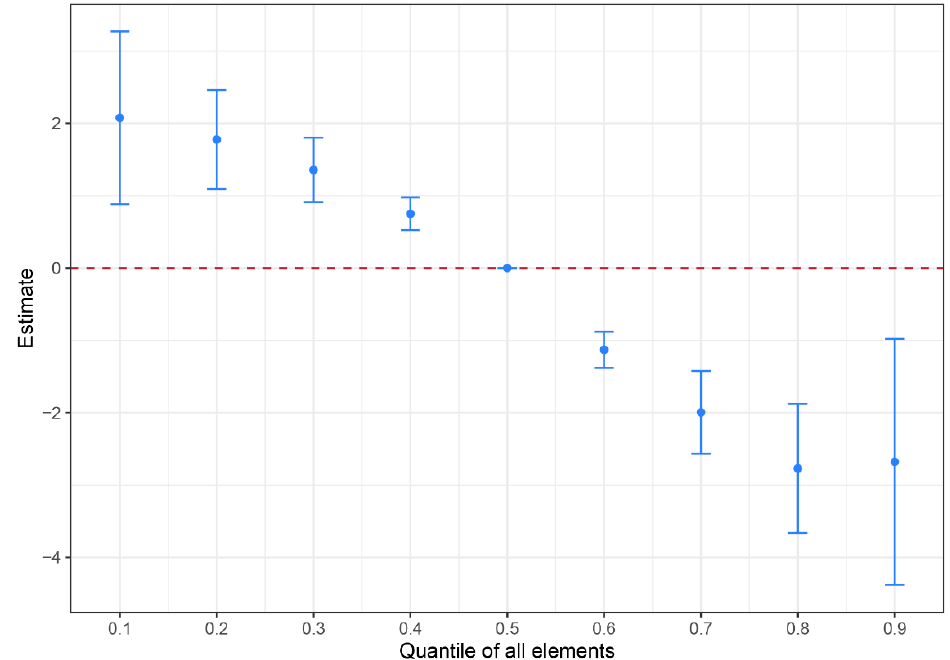
Figure 3. Overall effect of the seven elements on the risk of EC (Al, V, Mn, Ni, Zn, Se, Sr). The model was adjusted for smoking, drinking and family history of esophageal cancer.